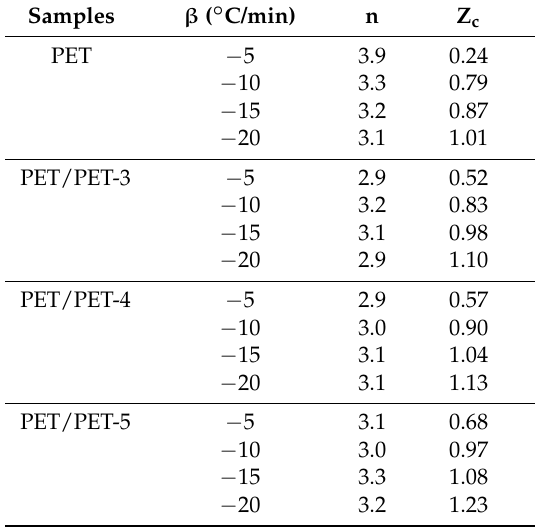
Table 2. Non-isothermal crystallization kinetic parameters based on the Jeziorny